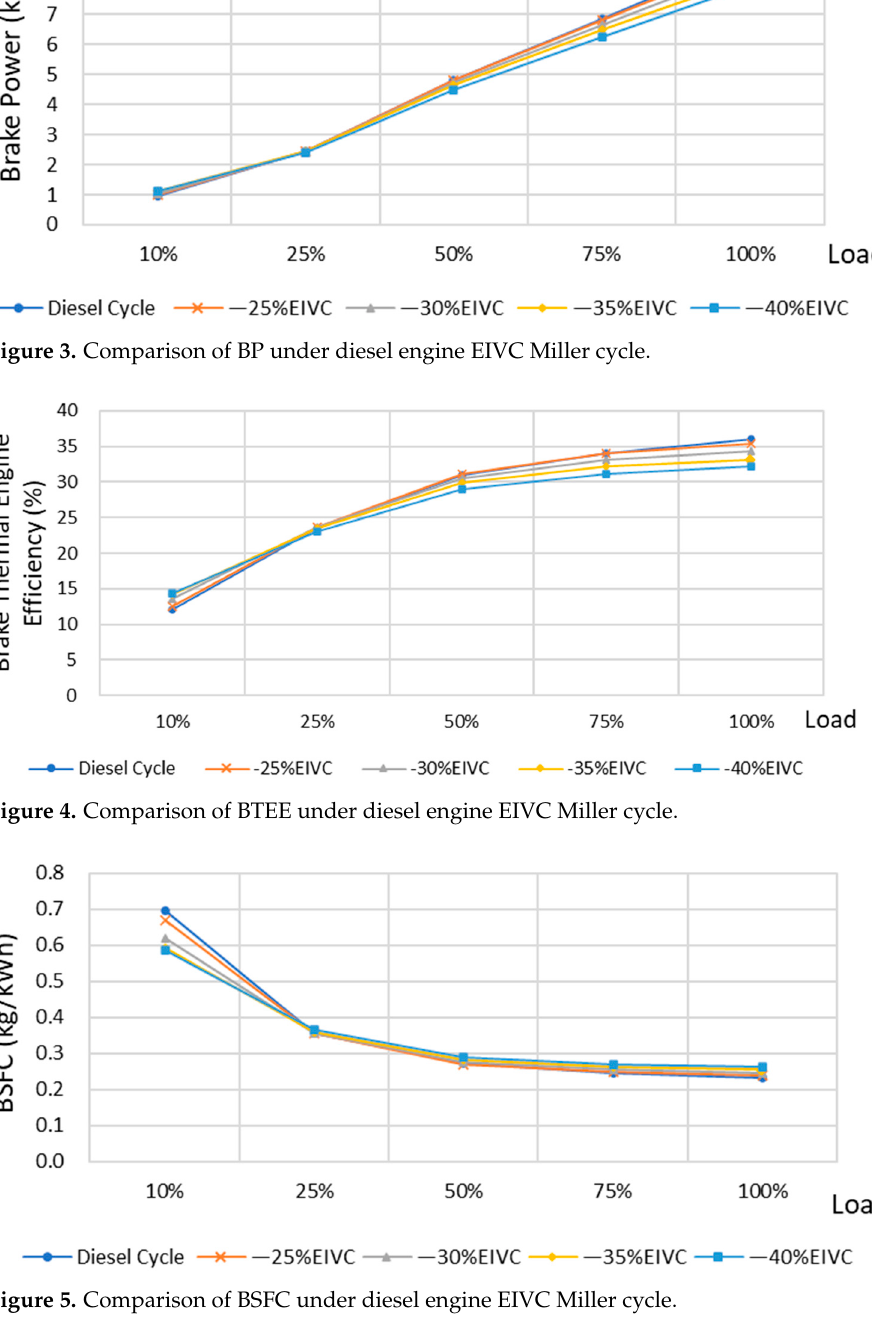
Figure 5. Comparison of BSFC under diesel engine EIVC Miller cycle.